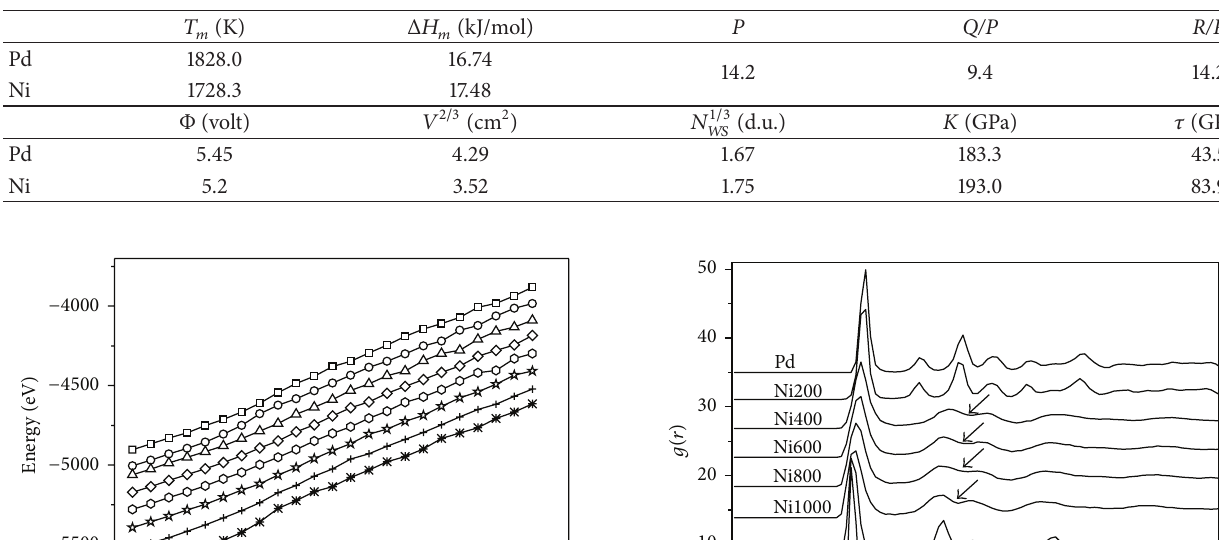
Table 2: Parameters for calculating forming energy of Pd-Ni binary alloy [24–26].